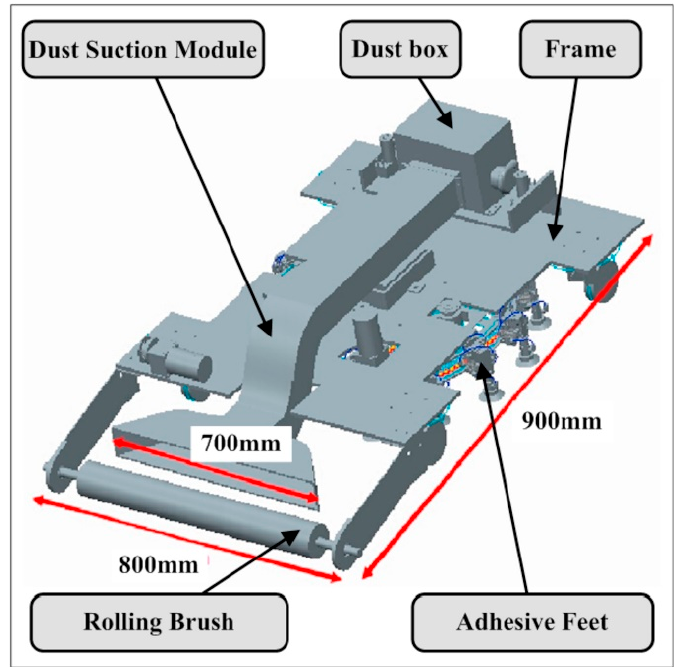
Figure 5. Structure of cleaning robot [22].